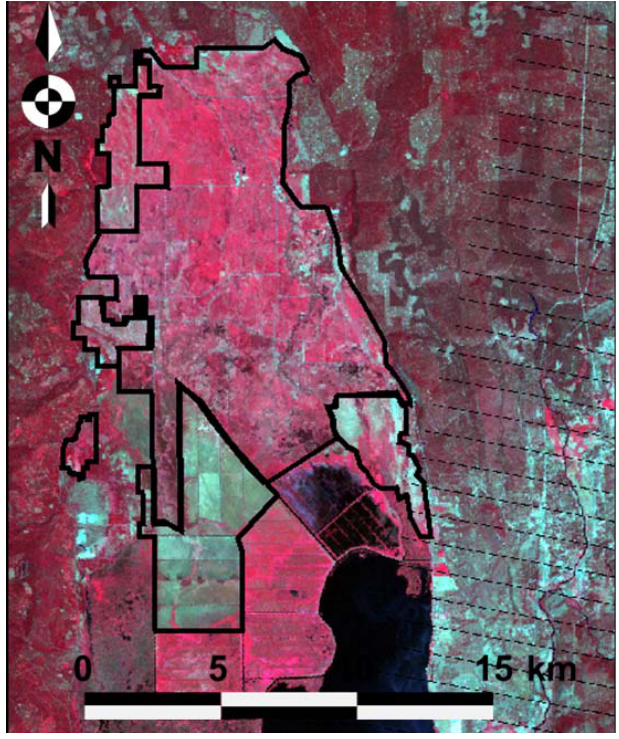
Figure 7. 27 July 2004 false color composite Landsat 7 image (bands 2, 3 and